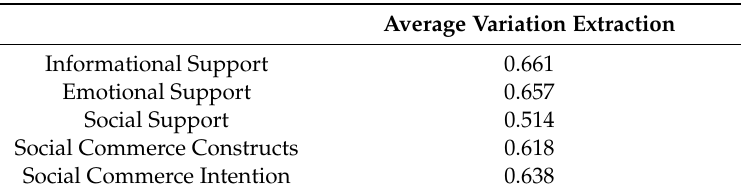
Table 3. Average variation extraction